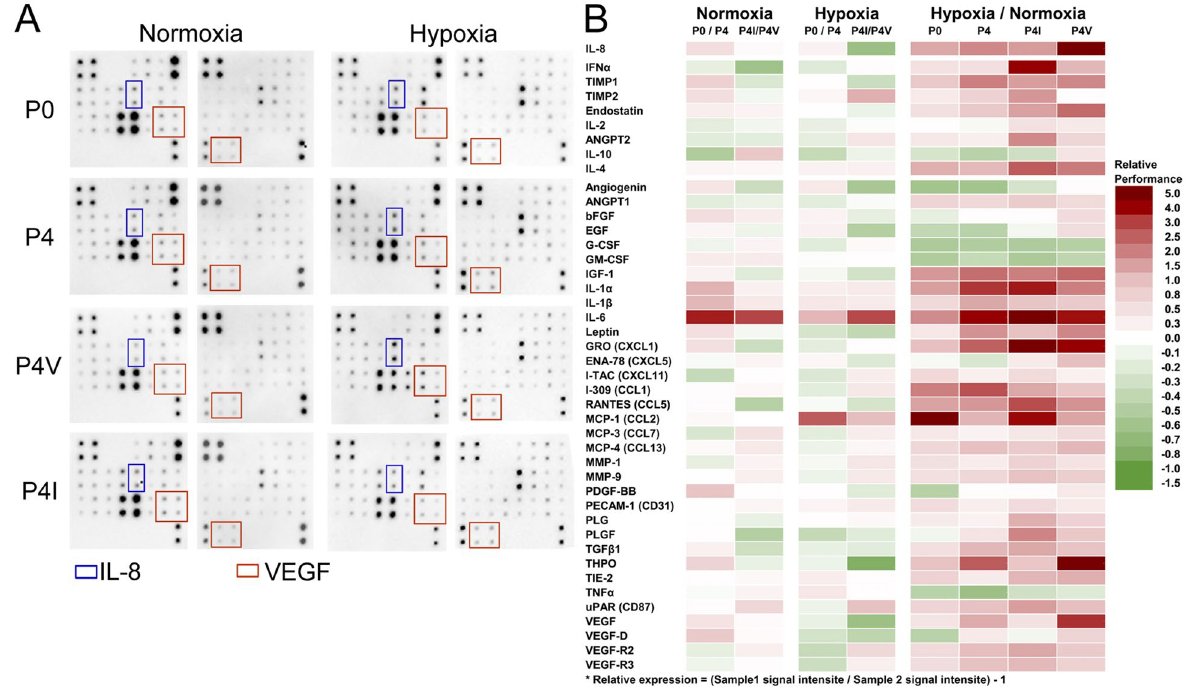
Figure 6. Low IGFBP3 expression is associated with a high expression of angiogenic proteins related to HIF-2α under hypoxia. ( A ) Dot data of angiogenesis antibody array in P0, P4, P4-V, and P4-I lysates under normoxia and hypoxia. IL-8 showed a similar expression pattern as VEGF. Both IL-8 and VEGF were more expressed under hypoxia than in normoxia. ( B ) Expression signals were presented in categories by importance related to hypoxia and functions related to vasculogenesis. (IL-8 was negatively correlated with HIF-1α and positively correlated with HIF-2α. The proteins listed: IFNα to IL-4 are proteins with anti-angiogenic abilities; angiogenin to VEGF-R3 are known as angiogenic proteins.) The dot signals were analyzed with Image Studio Lite version 5.2, and the relative expression levels were compared between the groups. Red represents a higher signal performance, while green represents a lower signal performance than the comparison cell. Excel 2016 was used to generate chart. Photoshop CS2 version 9 was used to assemble the figure.